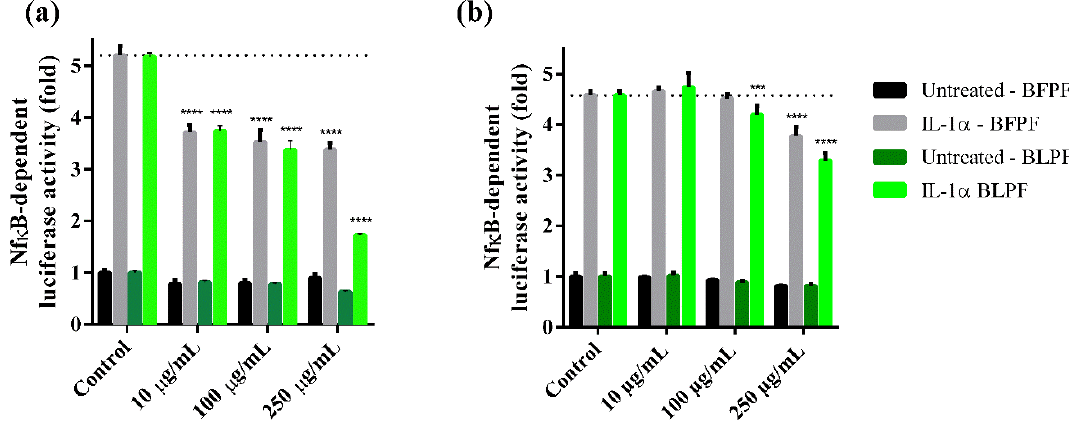
Figure 8. Dose-dependent effect of BFPF and BLPF on IL-1α induced NF-κB activation. R3/1-NF-κB cells were incubated for 18 h with different concentrations of BLPF (green) or BFPF (grey), followed by a 6 h stimulation with IL-1α, without the removal of medium containing the extract ( a ) or with the removal ( b ). Then NF-κB dependent luciferase activity was measured. Data are reported as mean ± SEM. The statistical significance difference of each concentration of BFPF and BLPF in respect to the control was analyzed by ONE-WAY analysis followed by the Bonferroni post-test. *** p < 0.001 and **** p < 0.0001.